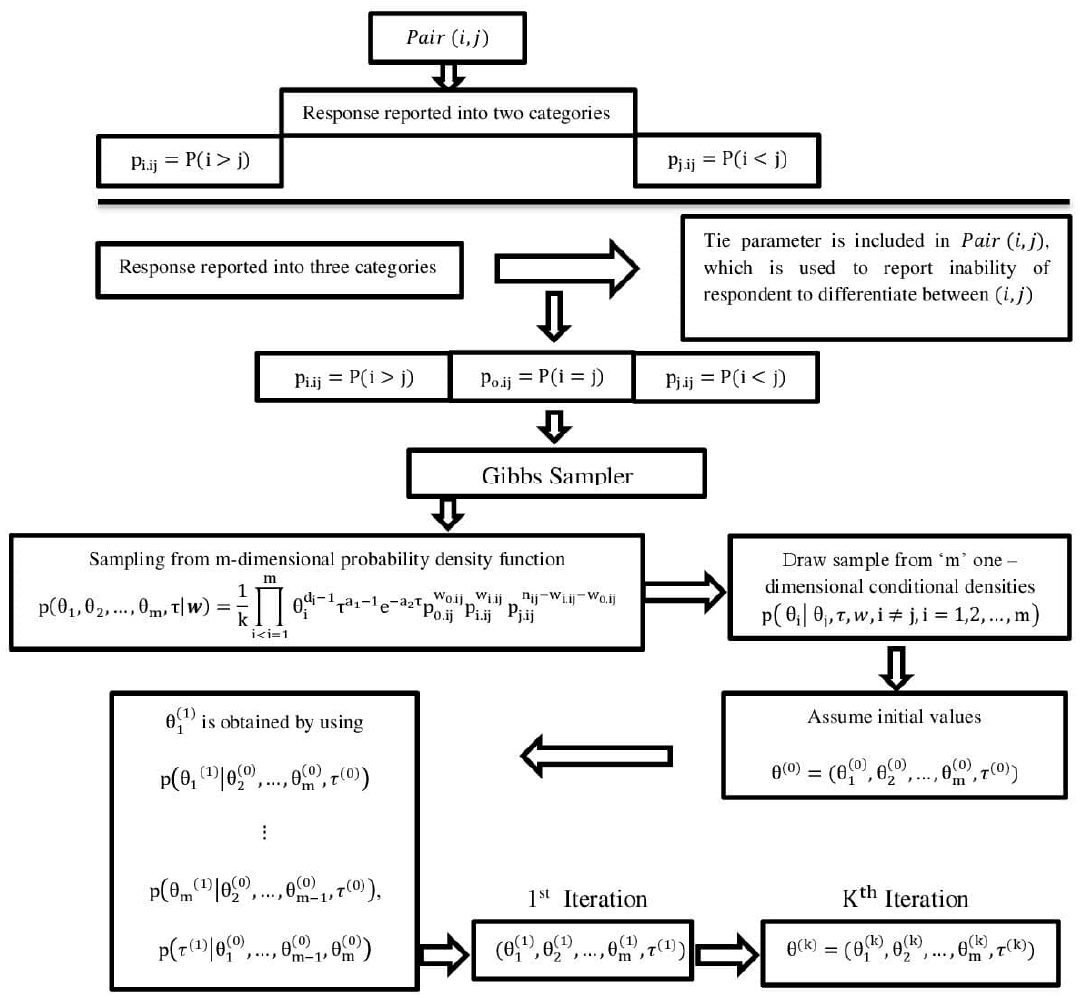
Figure 1. Flow diagram of the proposed scheme.